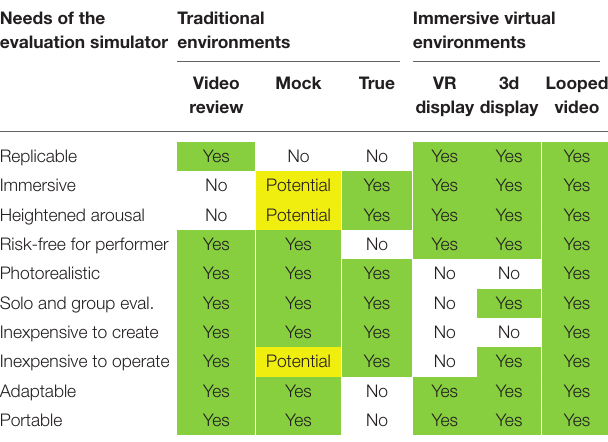
TABLE 1 | The qualities of traditional and immersive virtual environments (IVEs) in the training of evaluative skills and in research. Needs of the Traditional evaluation simulator